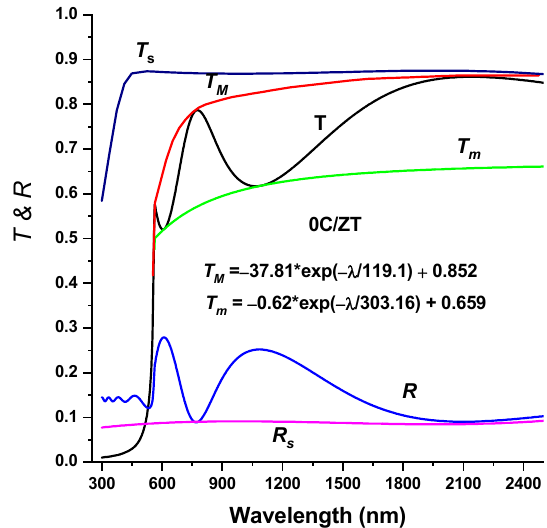
Figure 6. The spectral variation in the transmittance and reflectance of pure and Cu-doped ZnTe films with various Cu contents.